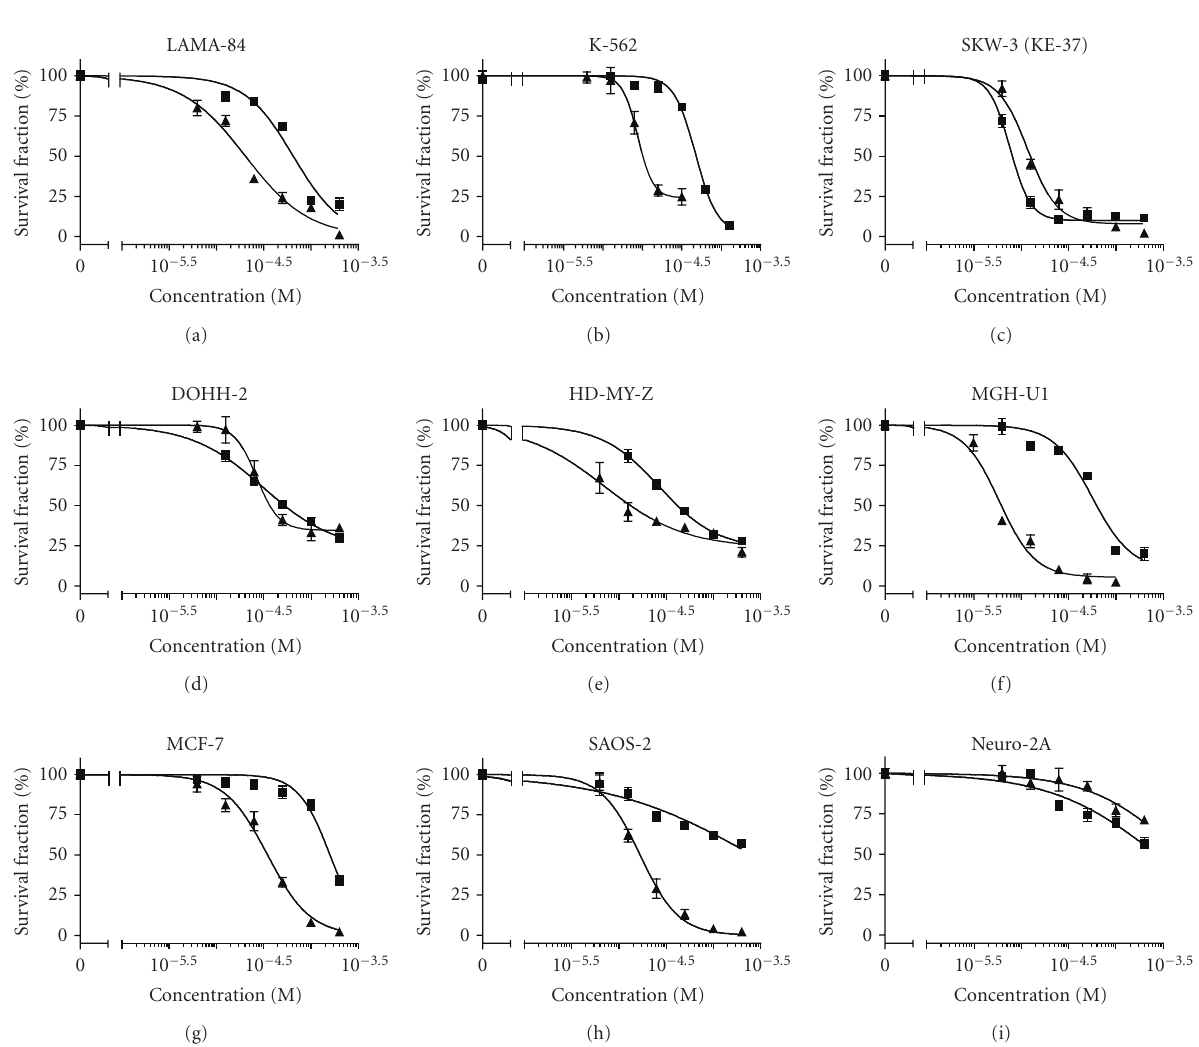
Figure 2: Concentration-response curves of [Au(II)Hp the MTT-dye reduction assay after 72-hour exposure. Each data point represents the arithmetic mean ± sd of eight separate